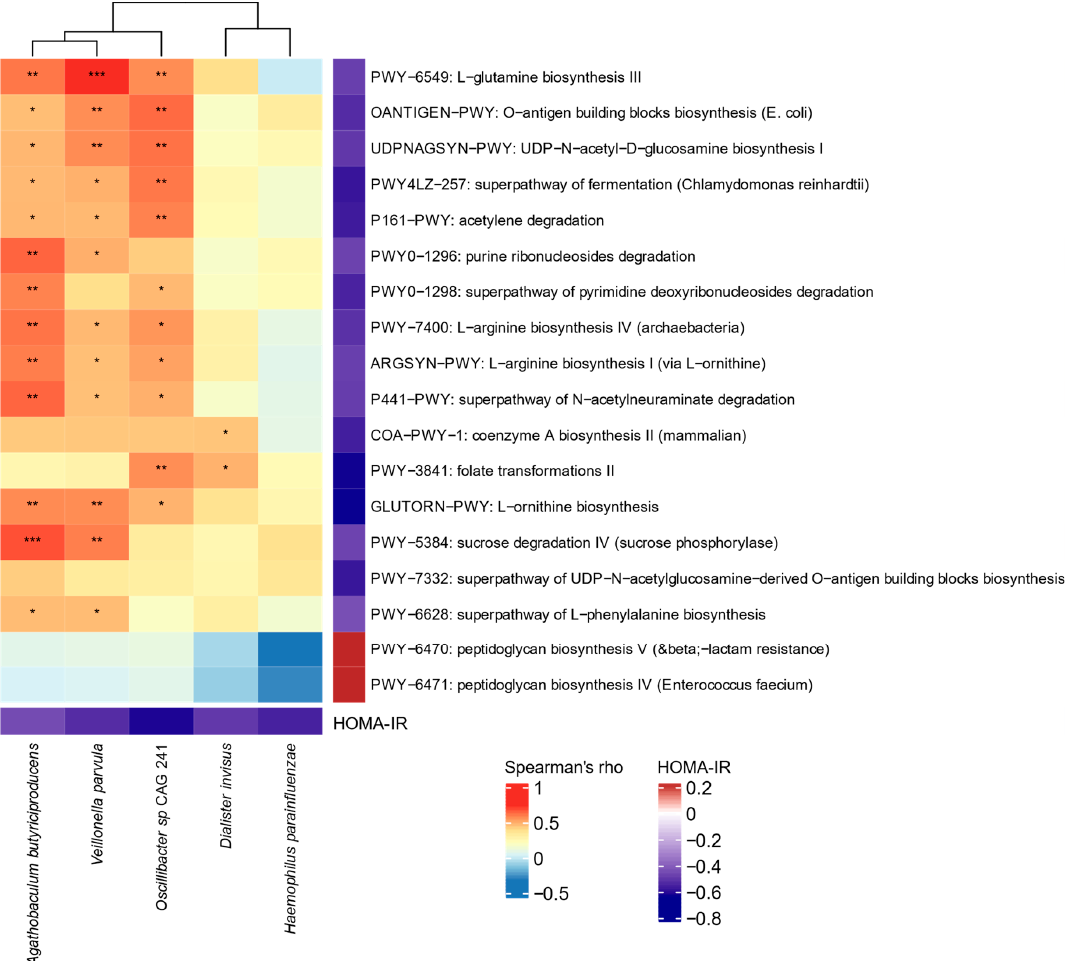
Figure 3. Heat map showing correlations of gut microbiome composition and functions with the homeostatic model assessment for insulin resistance (HOMA-IR) in 21 children with obesity (unadjusted analysis).